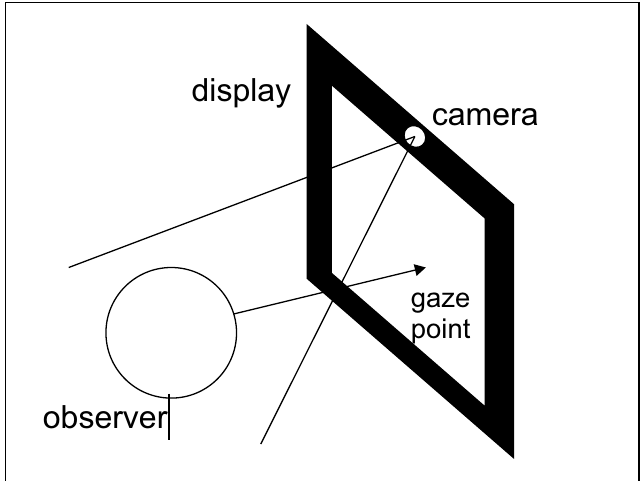
Figure 1. The experimental setup